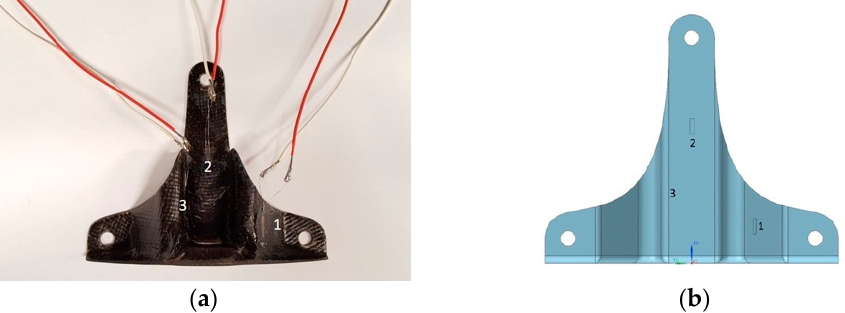
Figure 13. Strain gauges: ( a ) on component B, ( b ) Siemens NX 12 model with strain gages 1, 2, and 3.